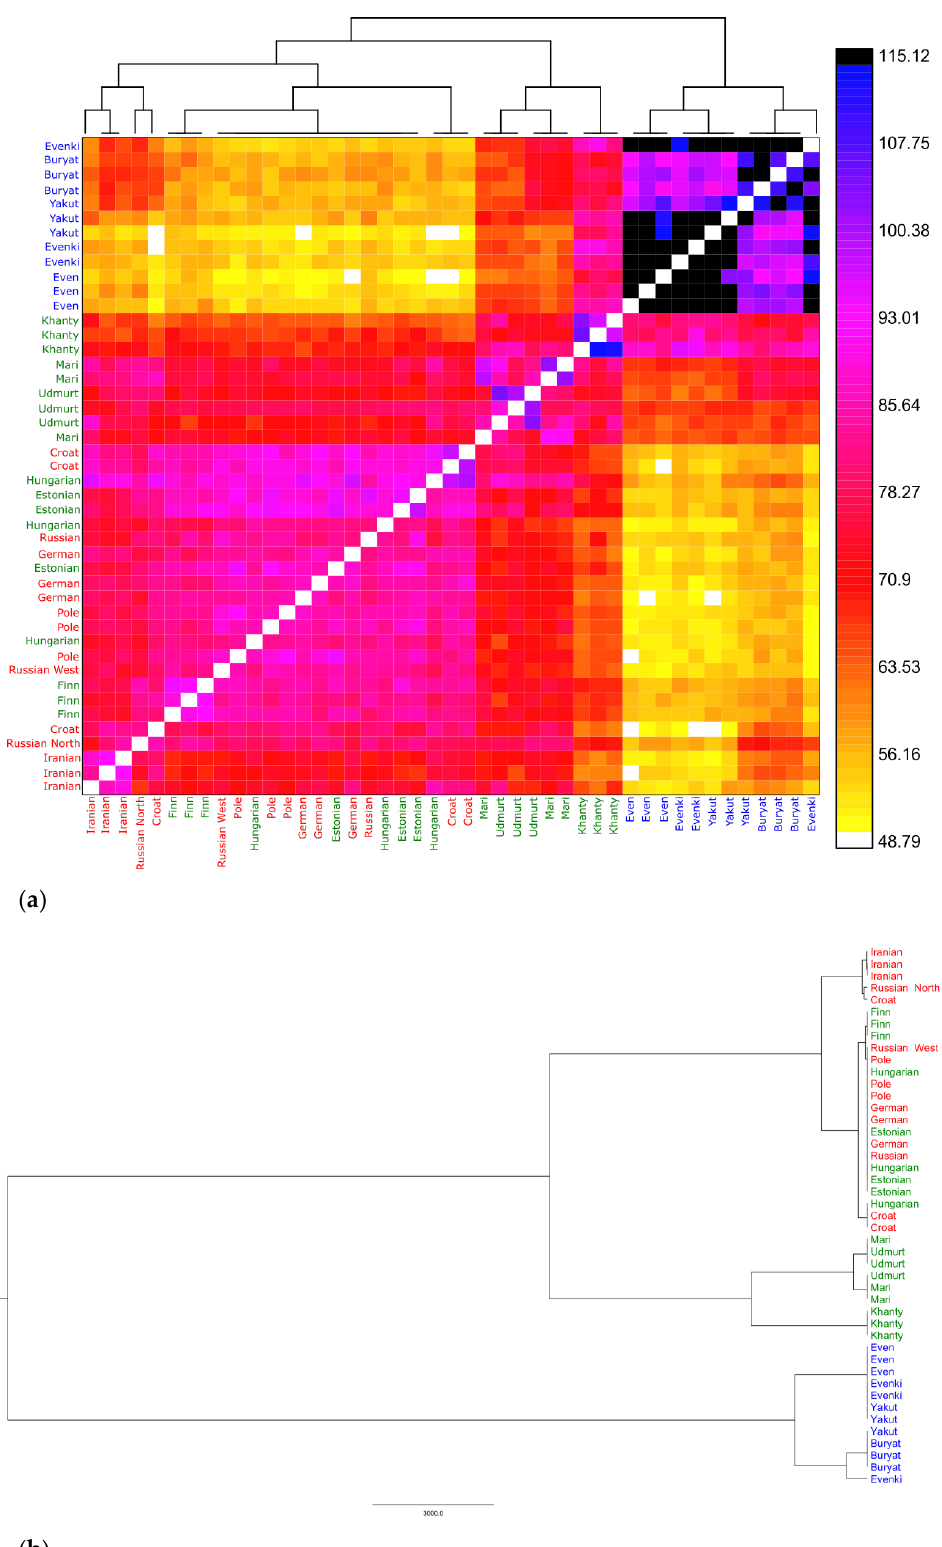
Figure 5. Estimates of shared ancestry between Eurasian individuals. ( a ) Co-ancestry heatmap. Each of the 51 individuals is represented as a row, where each pixel represents the level of co-ancestry (higher for darker colors) shared with each of the other individuals. ( b ) fineSTRUCTURE cluster analysis obtained from the co-ancestry matrix. Red = IE; Green = FU; Blue =